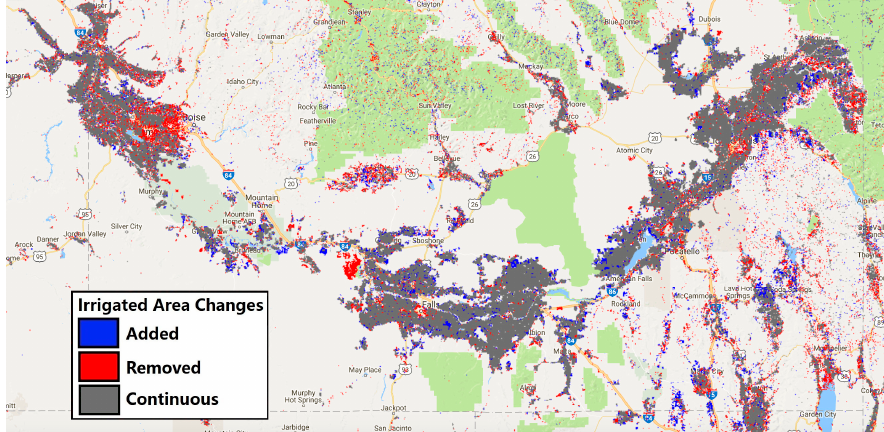
Figure 3. Long-term change in irrigated area, evaluated between the first five years in the time series (1984–1989) and the last five years in the time series (2011–2016).